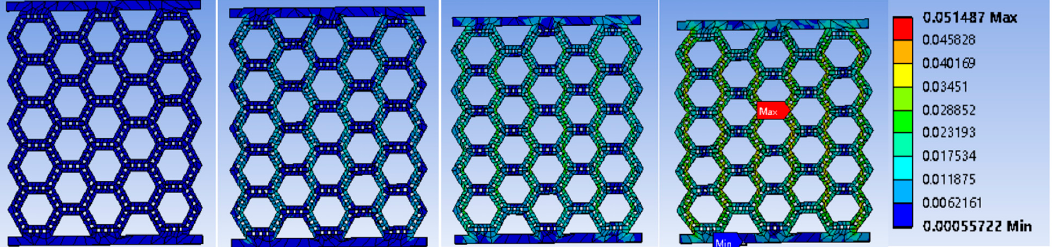
Figure 7. Representative strain maps in structure A10 at different deformation stages. (The com- pressive load increases from left to